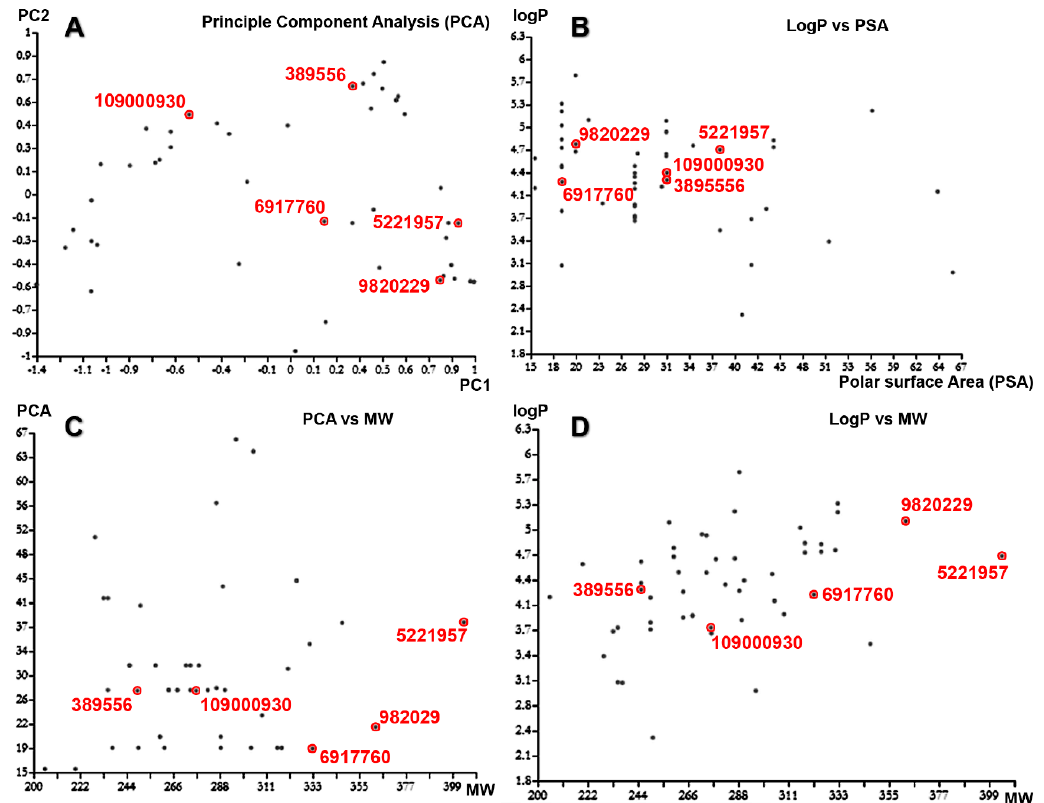
Figure 4. Principle component analysis (PCA) of 53 pharmacophores hit molecules. ( A ) The PCA showed various groups of compounds based on the Tanimoto coefficient (distance) between the first component (PCA1) against the second component (PCA2). ( B ) The logarithm of the calculated maximum of 5.8 logP and 66 PSA. ( C ) The molecular weight (MW) against the PSA showed that the compounds have a maximum of 66 PSA and 400 MW. ( D ) The molecular weight (MW) against the